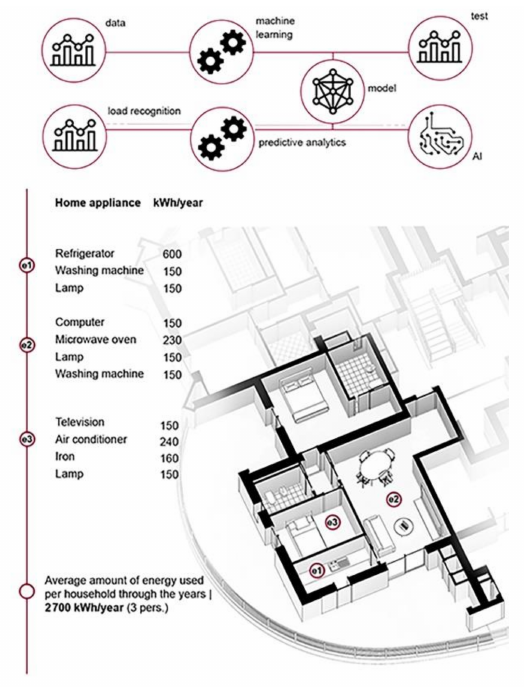
Figure 17. Energy loads forecasting and DT managing through